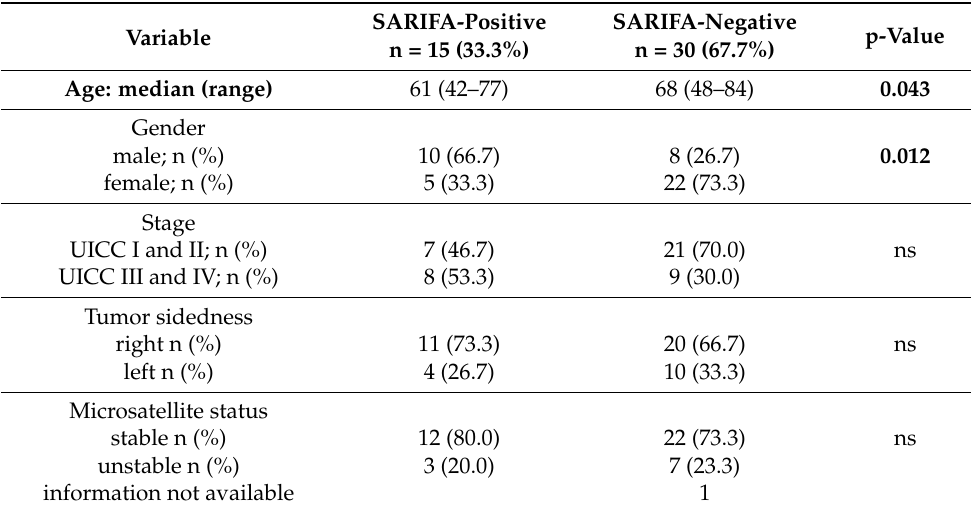
Table 1. Demographic and Disease Characteristics of CRC